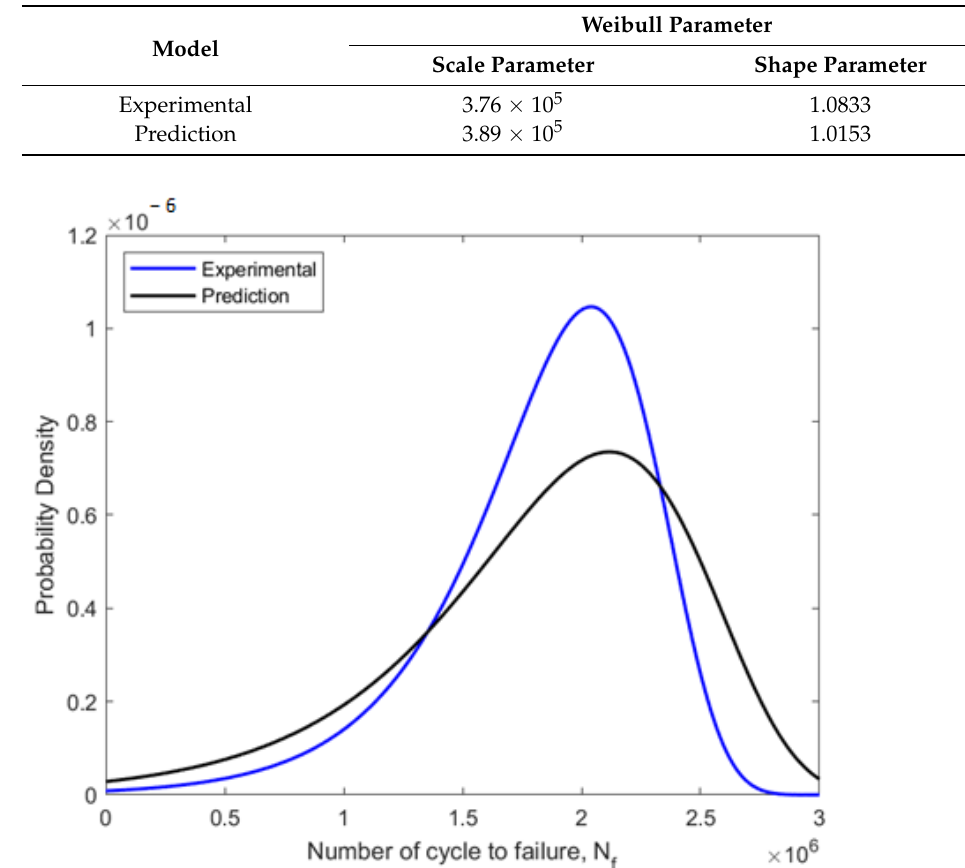
Figure 13. Weibull distribution PDF fitted using experimental and predicted fatigue data.